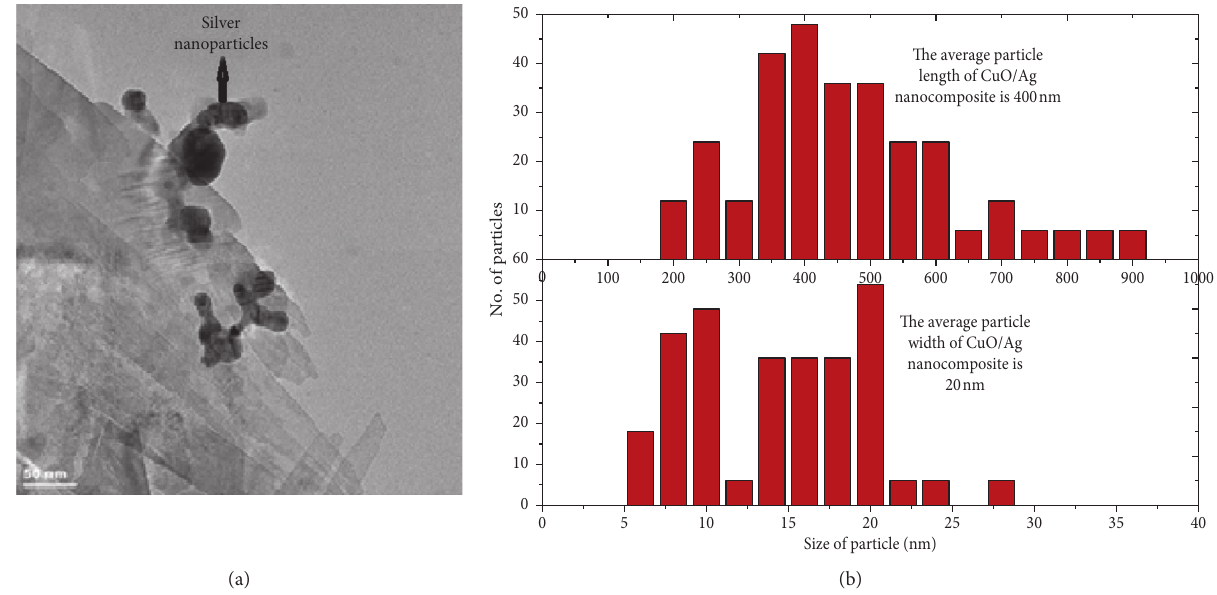
Figure 3: (a) TEM micrograph of CuO/Ag. (b) Particle size distribution of CuO/Ag nanocomposite. Silver nanoparticles